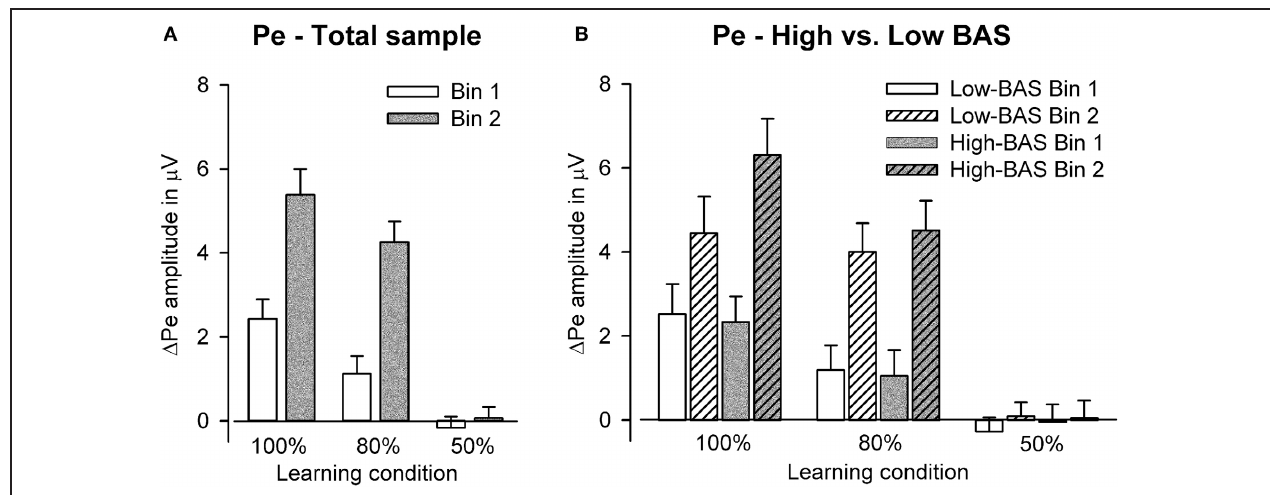
FIGURE 7 | Bar graphs show the amplitude of the (cid:2) Pe at Pz in Bin 1 and Bin 2 for (A) the total sample and (B) high vs. low BAS subjects.